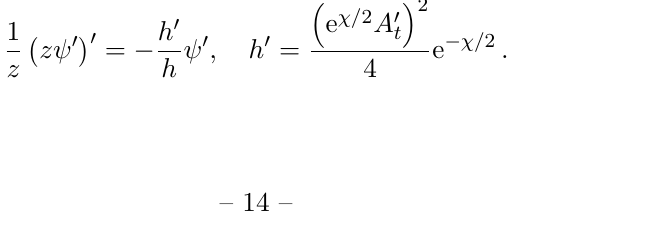
Figure 8 . A comparison of the analytical description (3.12) (red dashed curve) and the numerical one (solid blue curve) for Kasner transitions. We choose T = 0 . 33 T Kanser transitions. The approximation (3.12) is in excellent agreement to the numerical solution of the full equations of motion